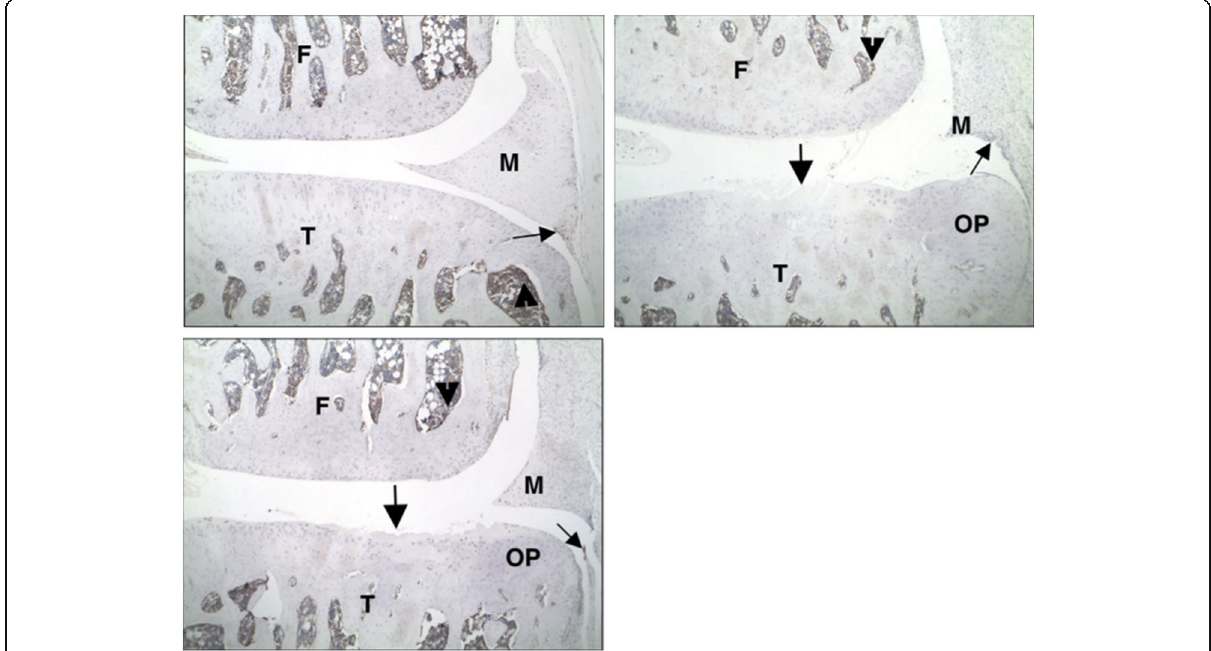
Fig. 5 TNF α staining on the medial tibial surface. a Uninjected left knee. b PBS injected in the right knee. c IA-BioHA (0.5 mg/rat) injected at Days 7, 14, and 21 in the right knee. The large arrow identifies a cartilage lesion. There are numerous TNF α -positive cells in the bone marrow (arrowhead) and minimal multifocal-positive cells in the synovium (small arrow). The disease process and IA-BioHA treatment did not result in a significant increase in TNF α immunostaining. F – femur; M – meniscus; OP – osteophyte; T – tibia. Images were acquired at 50x